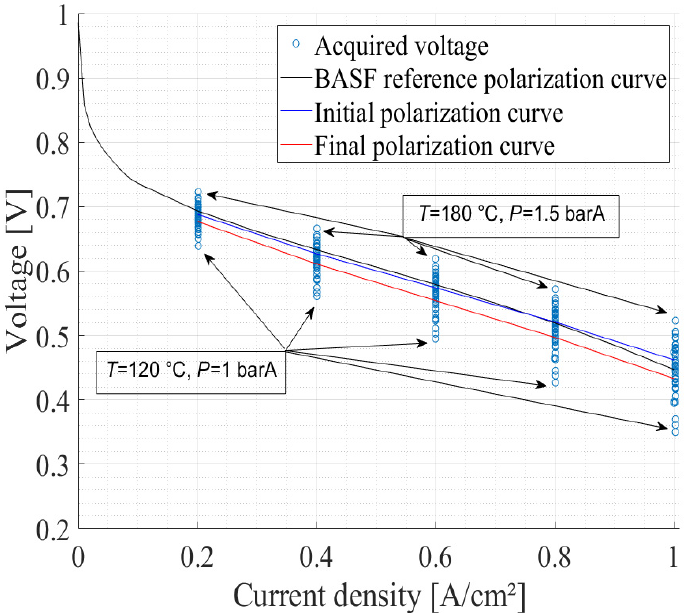
Figure 7. Representation of all the voltages measured during the design of experiments in pressure and temperature as a function of the current density. All series of data in pressure and temperature are not represented to lighten the graph. BASF, initial and final reference polarization curves from Figure 5 are reported.